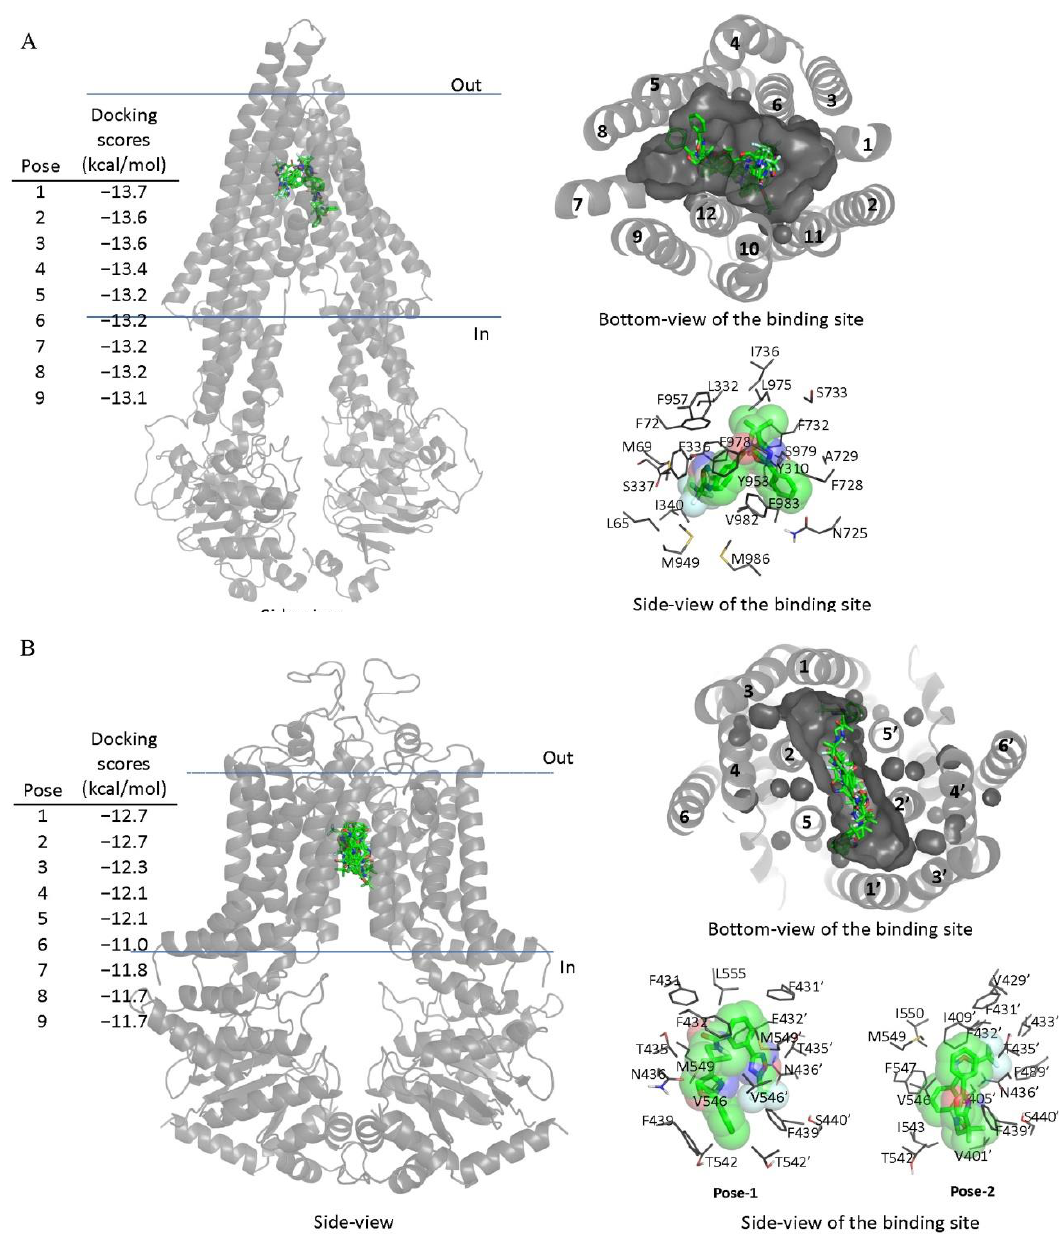
Figure 5. Docking of TMP195 in the drug-binding pockets of ABCB1 and ABCG2. Binding modes of TMP195 with ( A ) the inward-open structure of human ABCB1 (PDBID:6QEX) and ( B ) structure of ABCG2 (PDB: 5NJ3) obtained after exhaustive docking using AutoDock Vina software as described in Section 4. TMP195 is presented as a molecular model with atoms colored as carbon–green, nitrogen–blue, oxygen–red, florine–white. The docking scores of the first nine poses (tighter binding) are shown on the left. Cartoon representation shows all nine binding poses in the side- and bottom-view of each transporter. Binding-cavity is shown in dark gray from the bottom-view, and TM helix numbers are specified. TMP195 is presented in green sticks. The lowest energy poses for TMP195 in the transmembrane region of ABCB1 and ABCG2 are presented in dark gray lines to illustrate the residues that are within 4 Å of the ligand. Figures were prepared using the Pymol molecular graphics system, Version 1.7 Shrödinger, LLC.